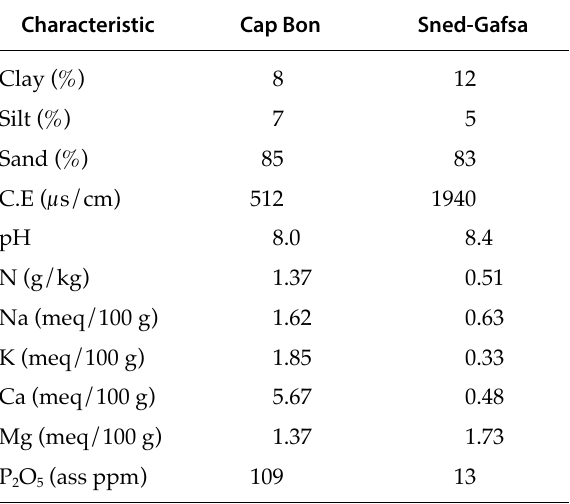
Table 1. Main physical and chemical characteristics of two soils used in this